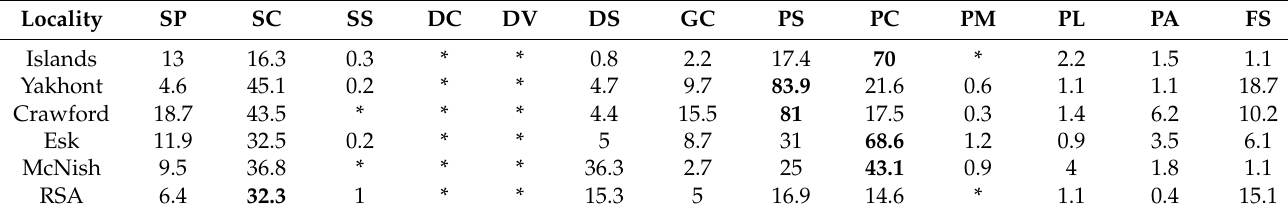
Table 1. Density of biodiversity by functional group and locality <1000 m depth. The data are: density in individuals or colonies/m 2 . The localities are islands of the Tristan da Cunha archipelago (Islands) and named seamounts. The functional groups are sessile suspension feeder pioneers (SP), sessile climax suspension feeders (SC), sedentary suspension feeders (SS), deposit feeding crawlers (DC), deposit feeding vermiform (DV), deposit feeding, shelled burrowers (DS), calcareous grazers (GC), scavenger/predator, sessile soft bodied (PS), scavenger/predator, sessile calcareous (PC), scavenger/predator, mobile soft bodied (PM), scavenger/predator, mobile calcareous (PL), scavenger/predator, arthropod (PA), and flexible strategy (FS). The most common functional group at each locality is shown in bold. Values of 0.1 or less are indicated by